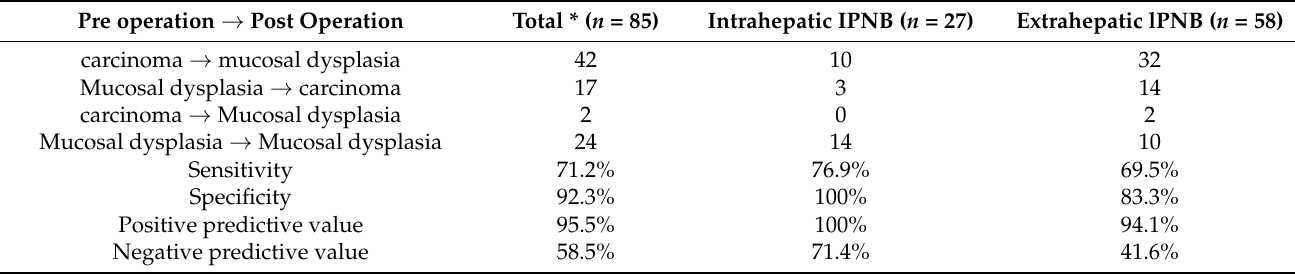
Table 4. Pathologic discrepancy pre- and